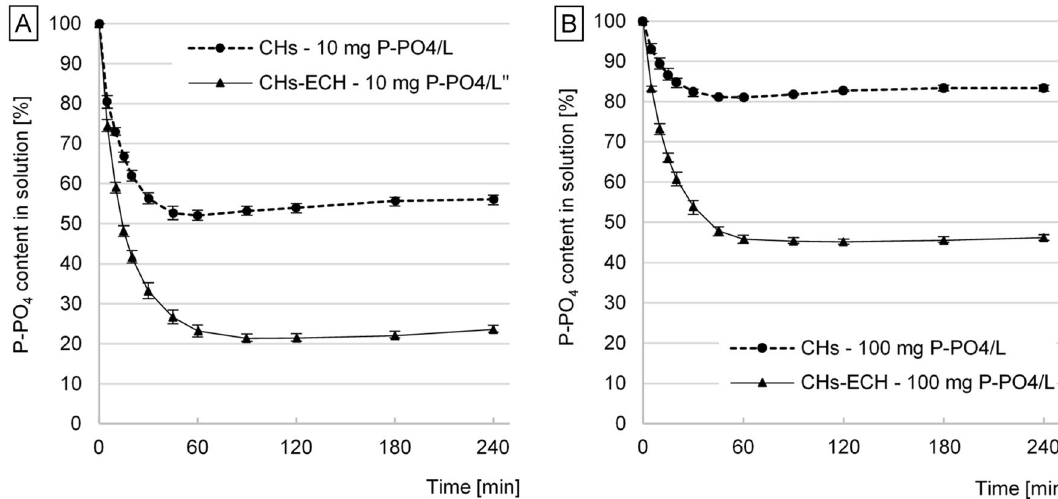
Figure 3. i-PO 4 sorption kinetics. ( A ) initial concentration: 10 mg P-PO 4 /L, ( B ) initial concentration: 100 mg